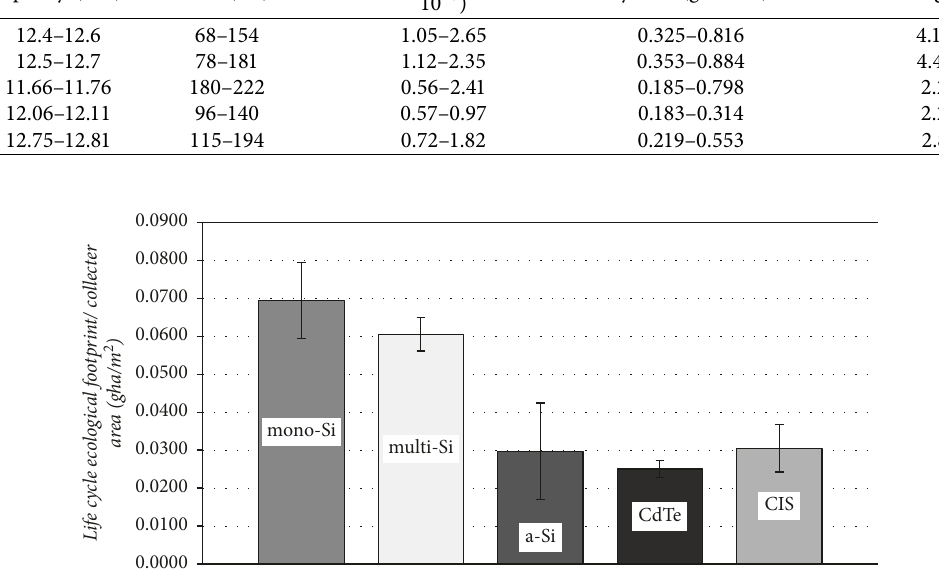
Figure 9: The life cycle EF of different PV module systems per m 2 collective area.